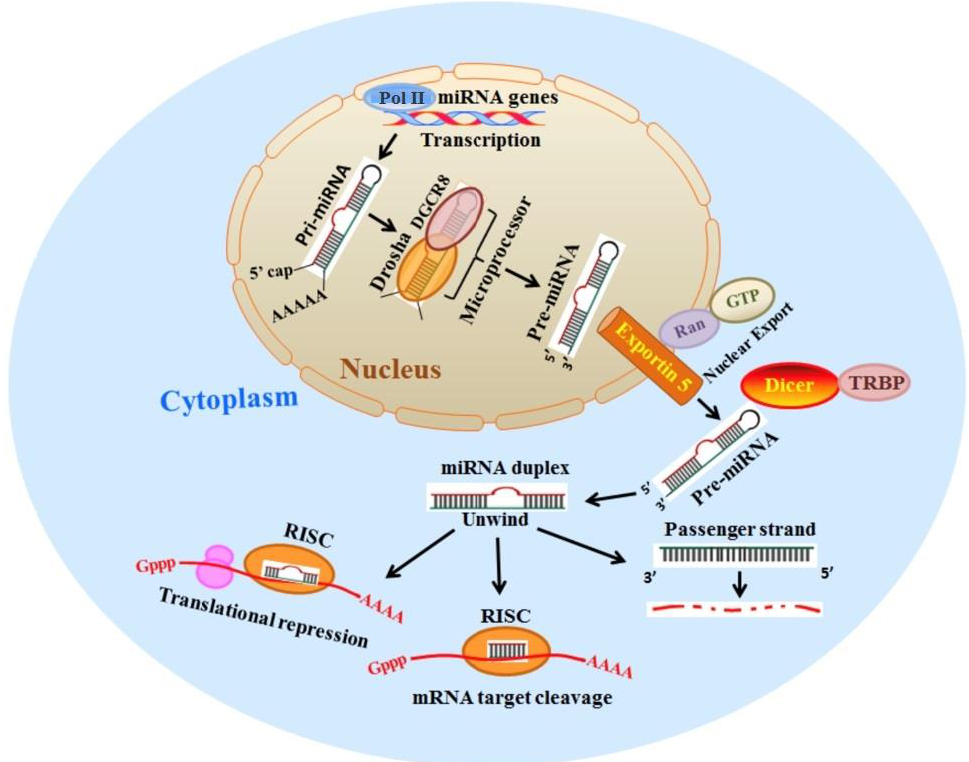
Figure 1. Biogenesis of miRNA and its functions. The miRNA synthesis starts in the nucleus where pri-miRNA transcript 100 to > 1000 nucleotides is generated by RNA polymerase II. Subsequently, pri-miRNA is cleaved by Drosha / DGCR8 to form ~70–100 nucleotides long hairpin loop pre-miRNA. Pre-miRNA is then transported from nucleus to cytoplasm through Exportin 5 and Ran-GTP6 wherein it is further processed by RNase activity of Dicer to 19–24 nucleotides double-stranded mature miRNA duplex. The miRNA duplex then loads onto Ago in the RISC complex and undergoes strand separation. The guide strand of the miRNA mediates gene silencing by degrading the target mRNA or interfering with the translational process. The passenger strand gets degraded. Adopted from [29] © 2013 Ranganna K, Mathew OM, Milton SG, Hayes BE under a CC-BY 3.0 license.